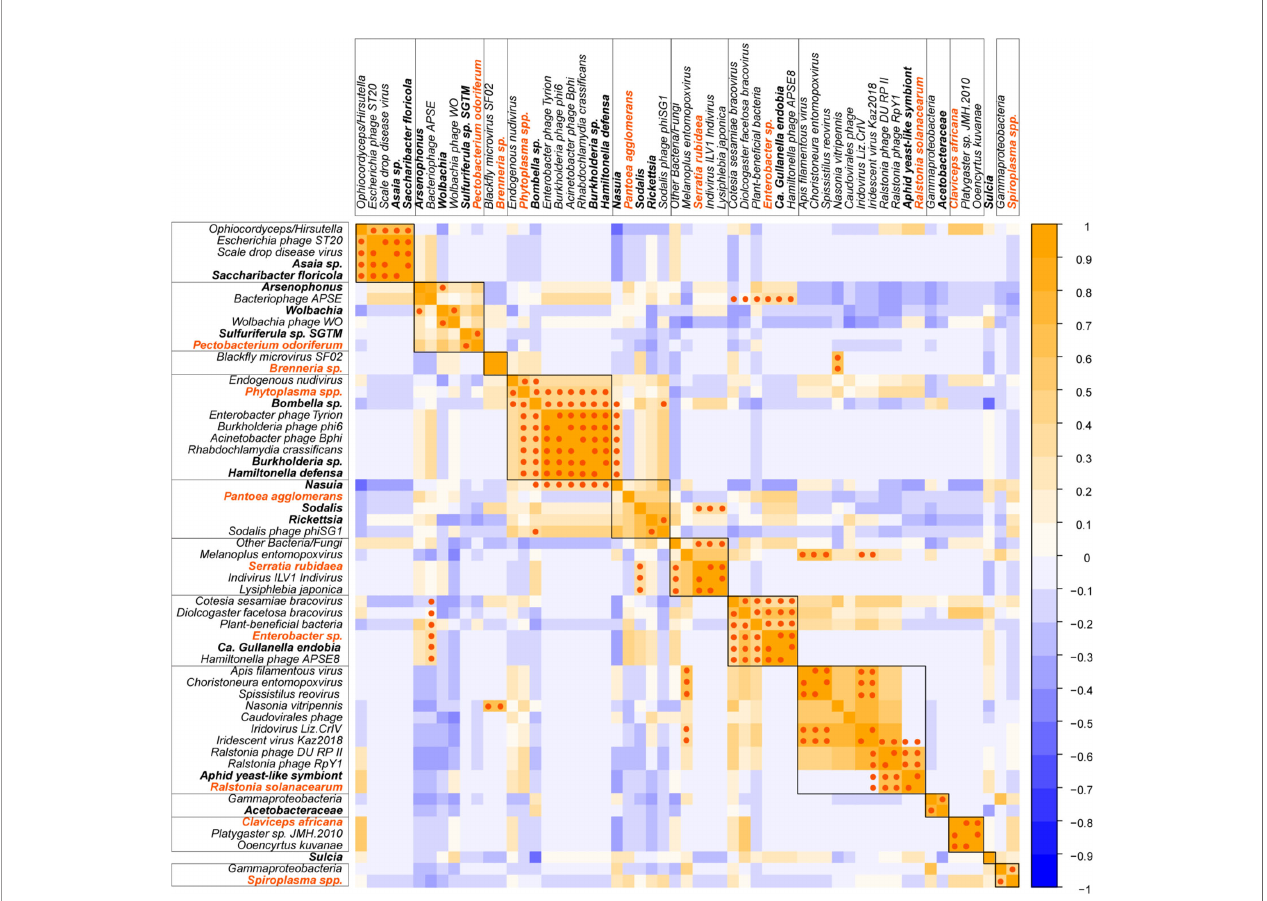
FIGURE 5 | Spearman correlation heatmap of symbionts, plant pathogens, and other microbes and viruses in membracids. Abundances were normalized to the membracid ’ s cytochrome oxidase (COI) gene coverage before analysis of correlation. Spearman ’ s rho R-values are depicted with blue to orange shading, from negative to positive. Statistically signi fi cant p-values after FDR correction using the Benjamini and Hochberg (1995) method, showing values <0.05 are represented with dark orange dots. Putative plant pathogen names are depicted in dark orange bold font, and putative primary or secondary membracid symbiont names are depicted in black